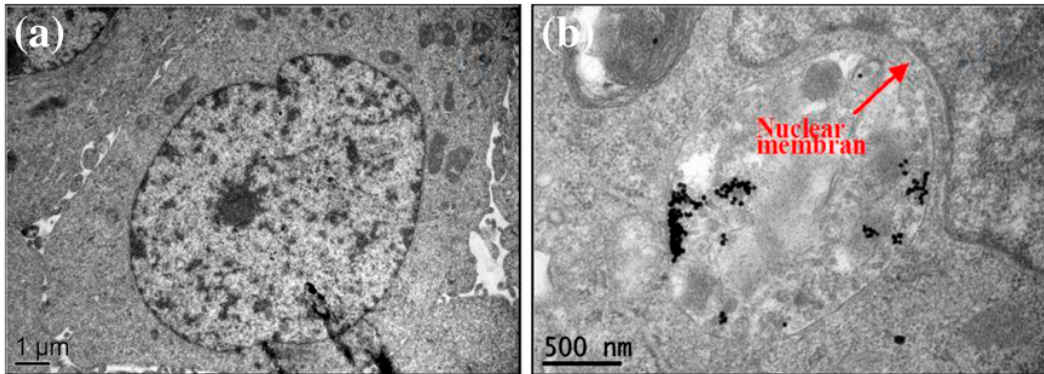
Figure 50. ( a ) TEM image of human breast cancer cell, of approximately 10 μ m diameter, showing cell structures, like nucleus and nuclear membrane; ( b ) TEM image of cell incubated with gold nanoparticles, which reside in cytoplasm and are enveloped into some vesicles (“lick up vesicles”); gold nanoparticles are clearly aggregated. Reproduced with permission from Zhu et al. [456] under Creative Commons 2.0 license (https://creativecommons.org/licenses/by/2.0/).